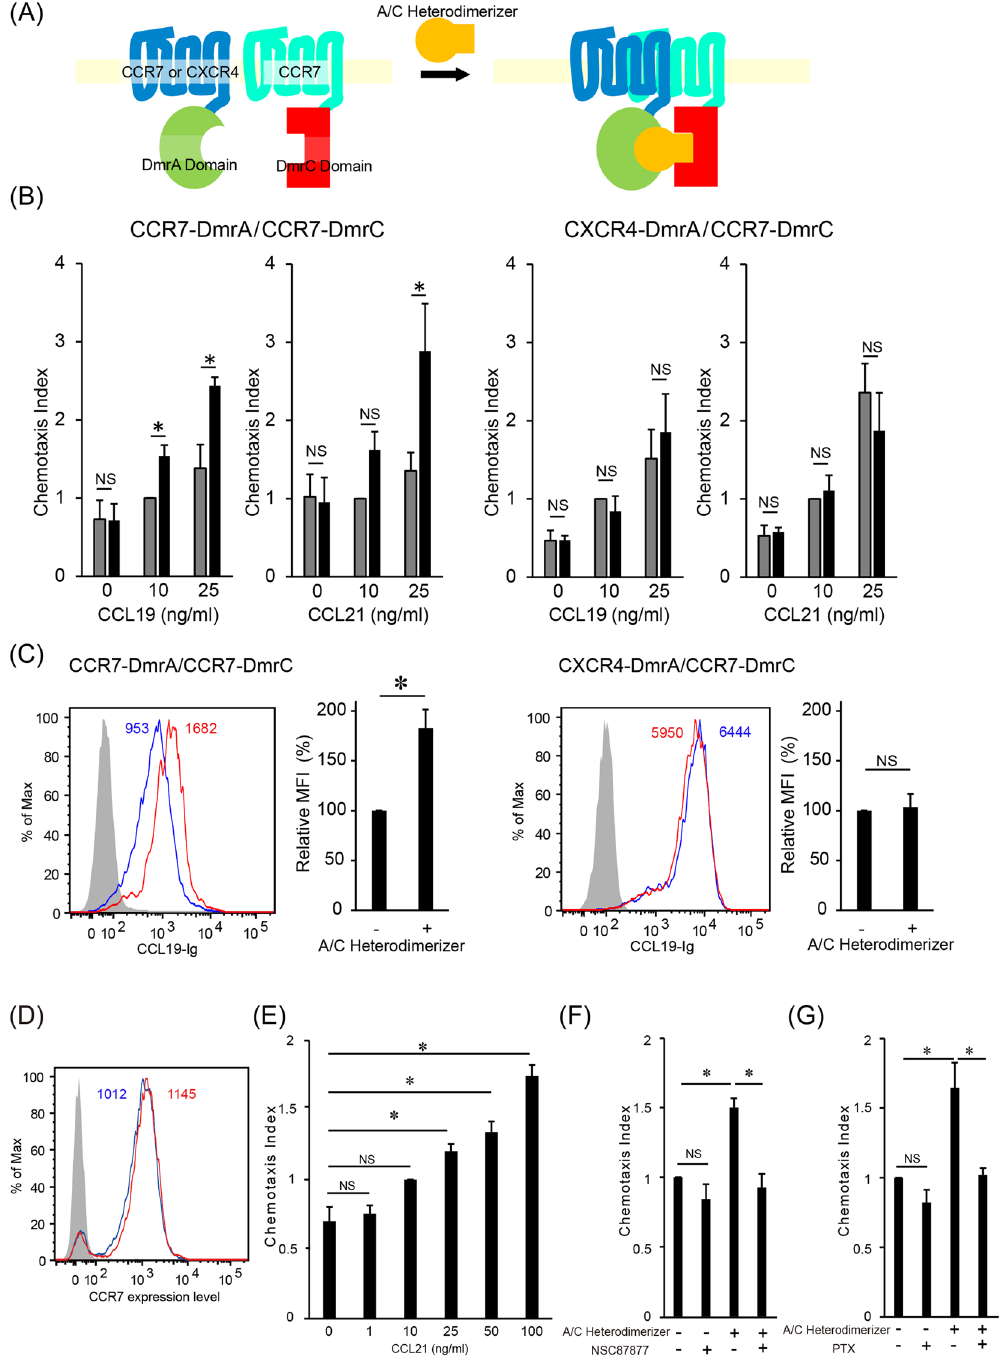
Figure 1. Induction of CCR7 homodimer formation enhances CCR7-dependent chemotaxis and CCL19 binding. ( A ) Schematic diagram of artificial CCR7 homo- and CXCR4/CCR7 heterodimer formation by a CID system. ( B ) CCR7-dependent chemotaxis after induction of CCR7 homo- (left) or CXCR4/CCR7 hetero (right) -dimerization was analyzed by the Transwell assay. CCL19 or CCL21 at the indicated concentration was added to the lower wells, and T cells were added to the upper wells in the presence (black bars) or absence (gray bars) of A/C Heterodimerizer. The relative chemotactic index shown is the ratio of the number of cells that migrated at the indicated concentration of CCL19 or CCL21 to those that migrated at 10 ng/ml CCL19 or CCL21 without A/C Heterodimerizer. Data represent mean ± SEM from three or four independent experiments. ( C ) Binding levels of CCL19-Ig in the presence (red) or absence (blue) of A/C Heterodimerizer. The gray-filled histogram shows the staining using isotype-matched control immunoglobulin. The median fluorescence intensity (MFI) is indicated on the histograms (left). The relative MFI of CCL19-Ig binding with or without A/C Heterodimerizer is shown (right). Data are shown as mean ± SD from three independent experiments. ( D ) CCR7 expression levels in CCR7-DmrA/CCR7-DmrC cells were examined by flow cytometry. Cells were stained with